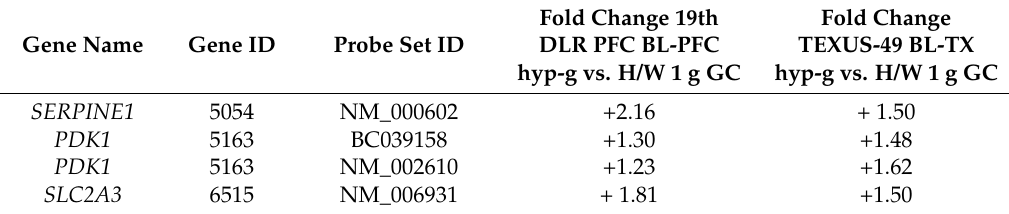
Figure 12. Time course of differential expression of 385 probeset IDs in human U937 cells after hypergravity exposure (list of probe sets in Supplementary Table S1). Human U937 cells were exposed to 20 s and 75 s of hypergravity. The probe sets are grouped according to their regulation after the two exposure times. Continuous response means that the probe sets are either up-regulated or down-regulated at both time points. Adaptation is either the disappearance of the hypergravity-induced effect or regulation in the opposite direction after 75 s. Late response is a regulation that only appears after 75 s. For the abbreviations of the experiment group names see Table 1. Table 11. Differentially regulated probe sets in a continuous manner in 20 s and 75 s of hypergravity identified in human U937 cells in the 19th DLR parabolic flight and TEXUS-49 suborbital ballistic rocket campaigns. Four probe sets, belonging to three genes were differentially regulated with respect to both altered gravity platforms. Plus: significantly up-regulated probe sets ( p -value < 0.05). FCs are ratios between the averages of linear expression values. If the ratio is <1, FC is calculated as the negative reciprocal of the ratio. For the abbreviations of the group names see Table 1.